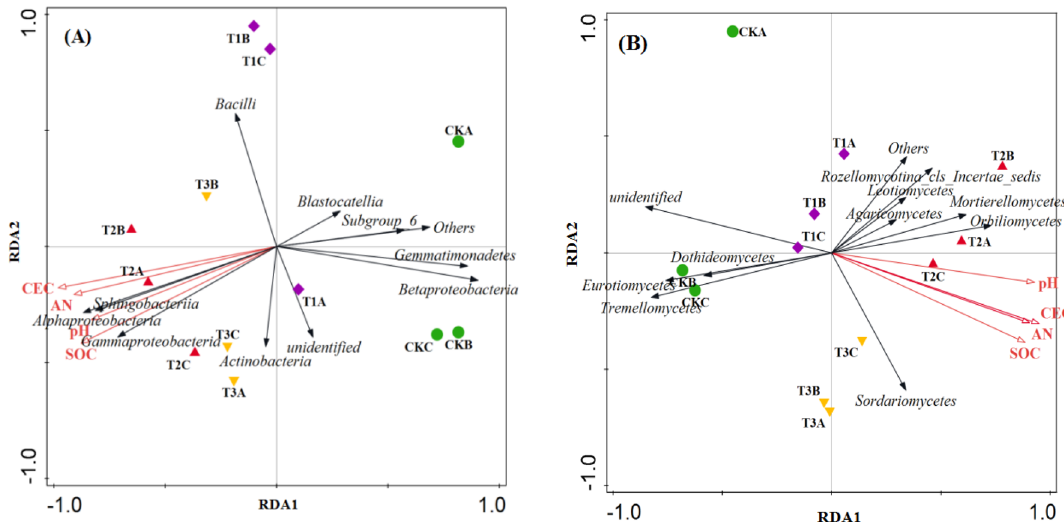
Figure 5. Redundancy analysis based on bacterial community (A) and fungal community (B) and environmental factors including the pH value, cation exchange capacity (CEC), soil organic carbon (SOC) and alkali-hydrolysable nitrogen